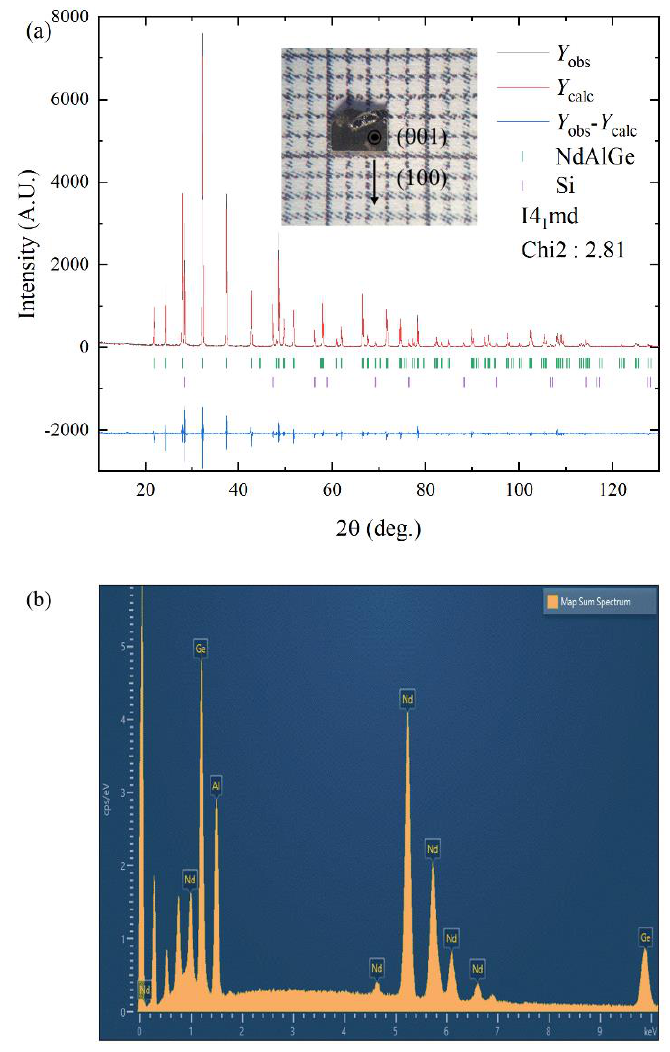
Figure 1. ( a ) Powder X-ray diffraction(XRD) of pulverized NdAlGe single crystals, inset: Crystal image and directions. ( b ) Energy dispersive X-ray spectroscopy (EDX) of NdAlGe.